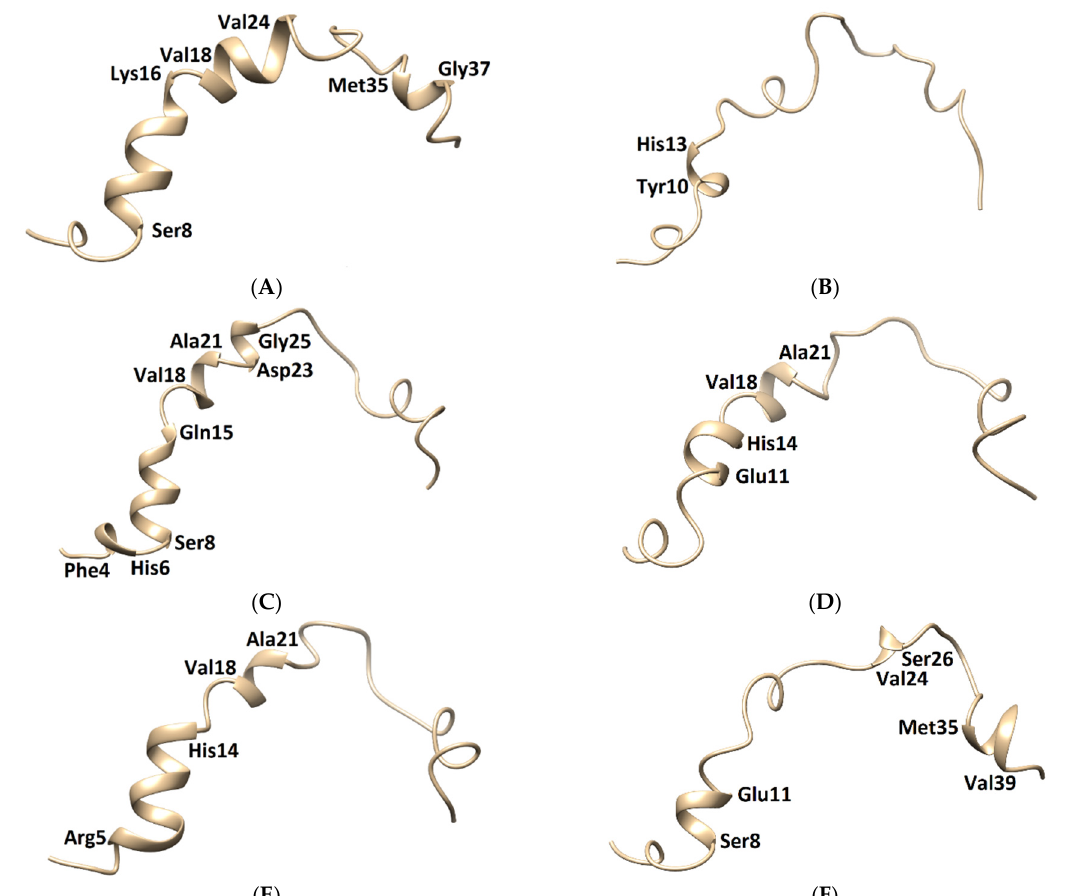
Figure 9. Three-dimensional structures of the A β 1–42 monomers. ( A ) The NMR structure, with Model 3 and the other models taken in the last frames from ( B ) TGN1, ( C ) TGN2, ( D ) TGN3, ( E ) TGN4, and ( F ) no ligand (only monomer) models, showing the conformational transformed structures.